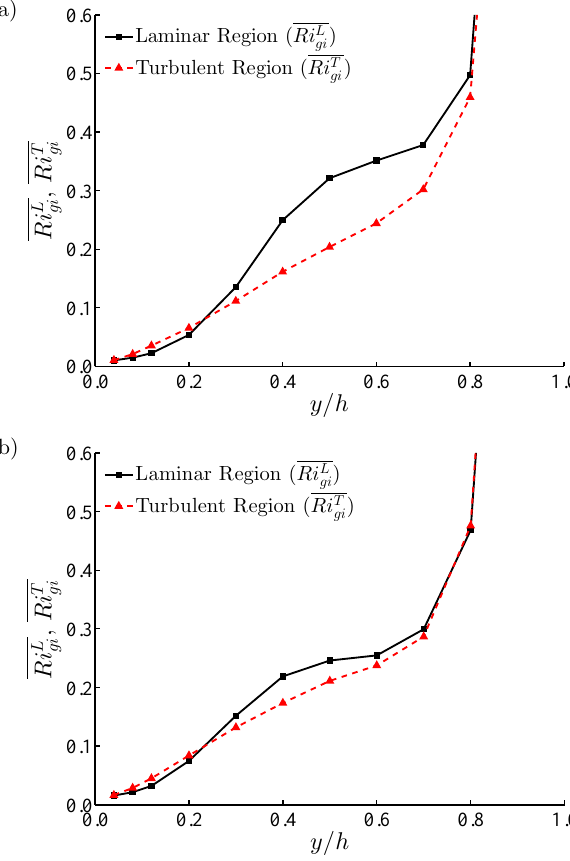
Figure 18. Profiles of plane-averaged Ri g in the turbulence and lam- inar regions ( Re τ = 180) (a) Ri τ = 120, (b) Ri τ = 240.